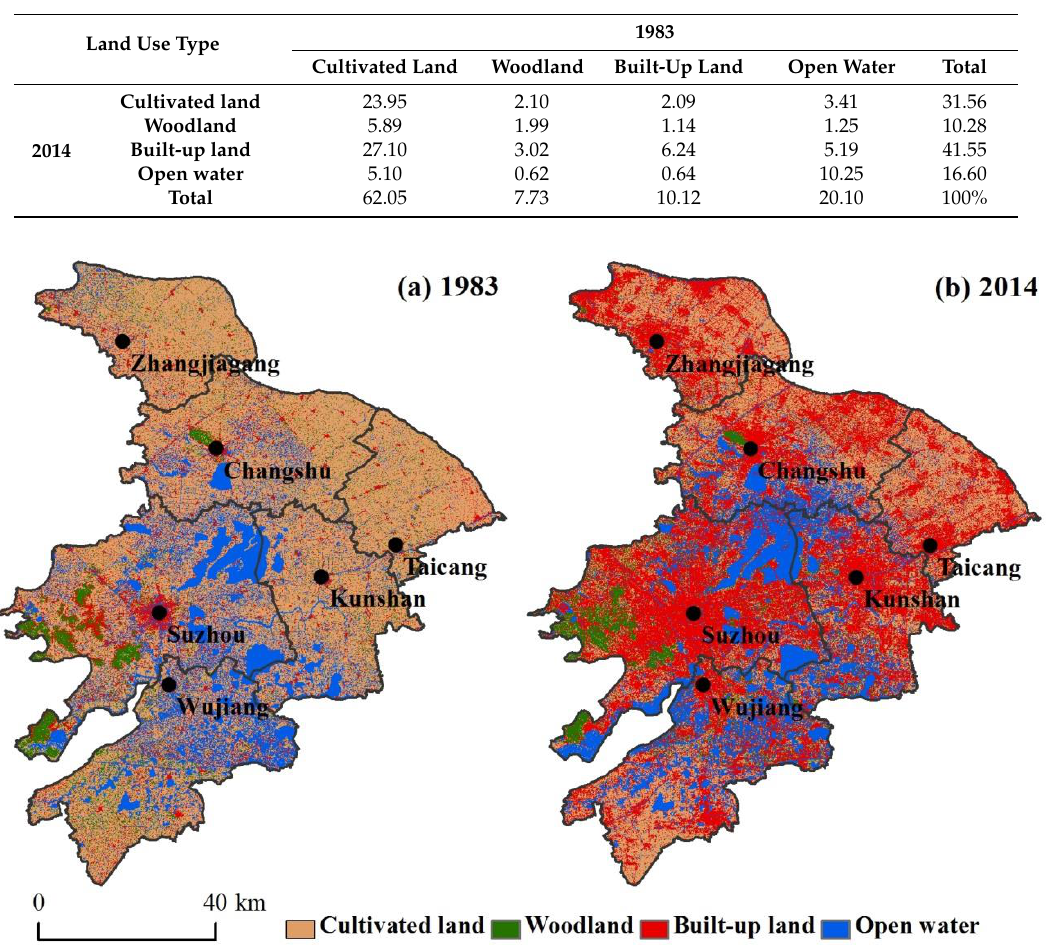
5658 Figure 4. River systems changed in length at each time.